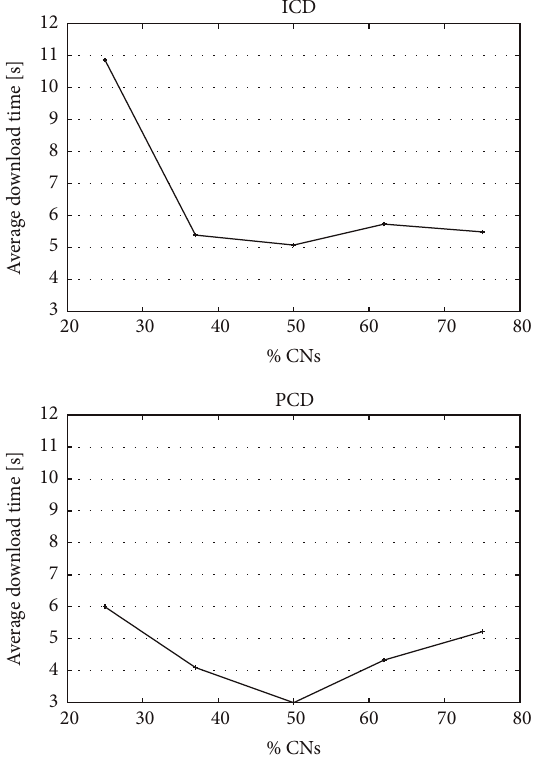
Figure15:AveragedownloadtimeinICDandPCDagainstdifferent ratios of CNs within the VANET.